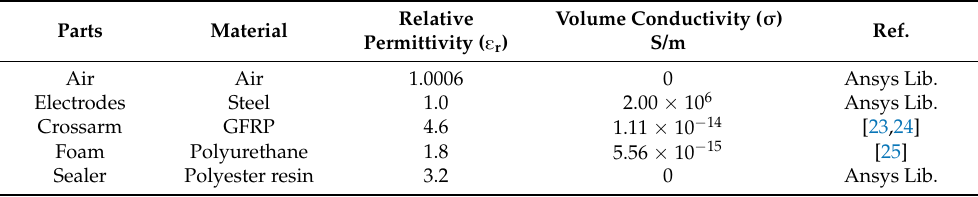
Table 2. Characteristics of PU foam used in the simulation [25].